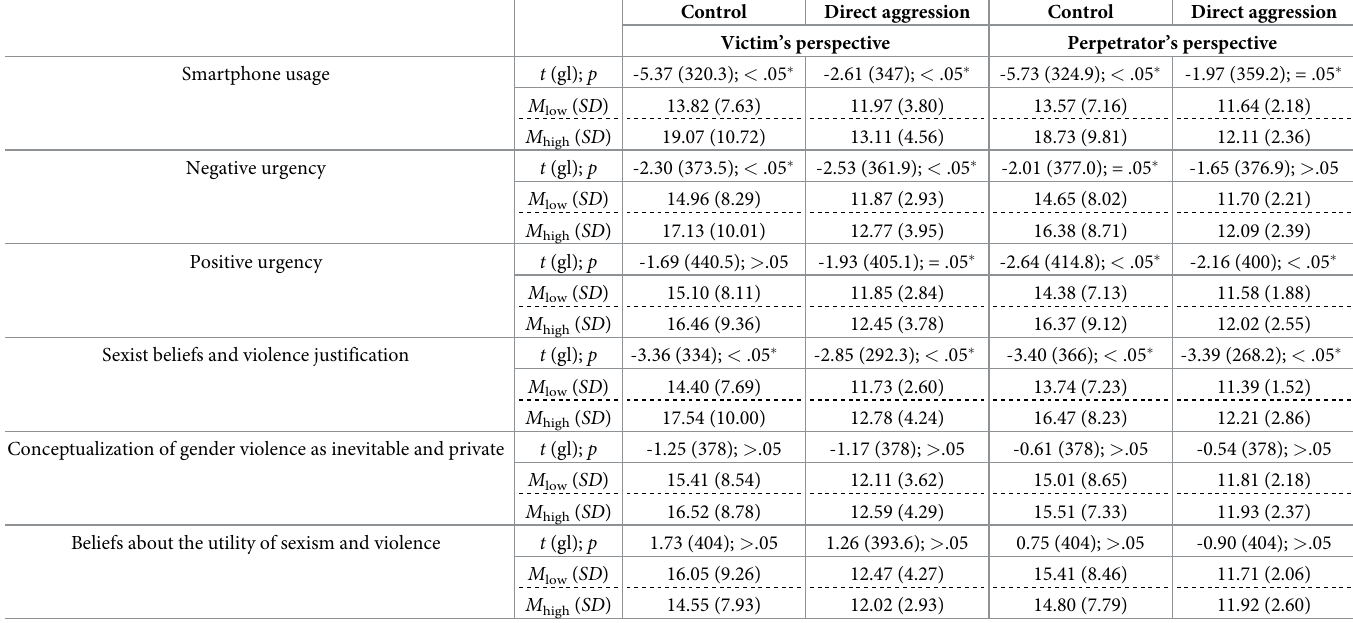
Table 3. Descriptive and t-test results for cyber-dating abuse (control and direct aggression) from the victim and perpetrator perspectives. Control Direct aggression Control Victim’s perspective Perpetrator’s